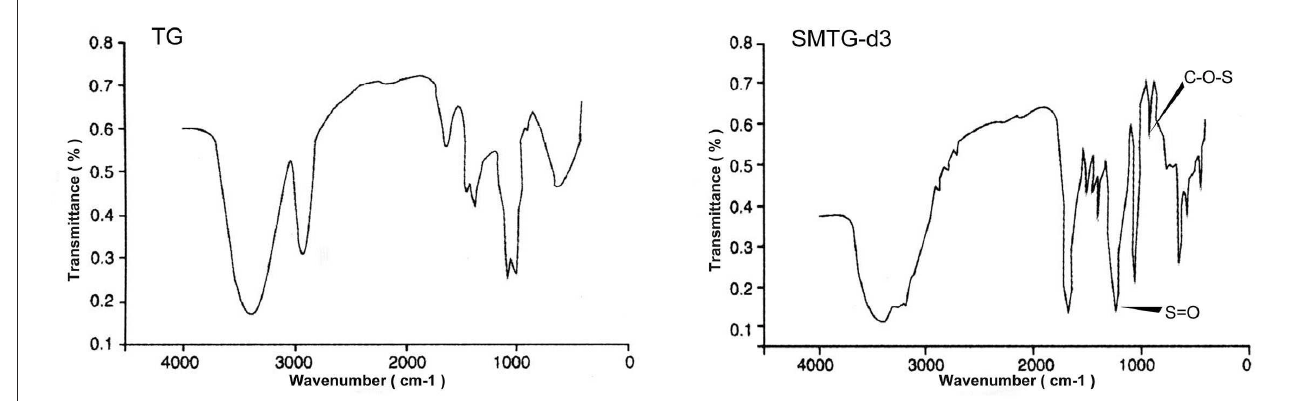
FIGURE1 Fourier-transform infrared (FT-IR) spectroscopic analysis of TG and SMTG-d3 TG, total ginsenosides; SMTG-d3, sulphation-modified total ginsenosides derivative-3.